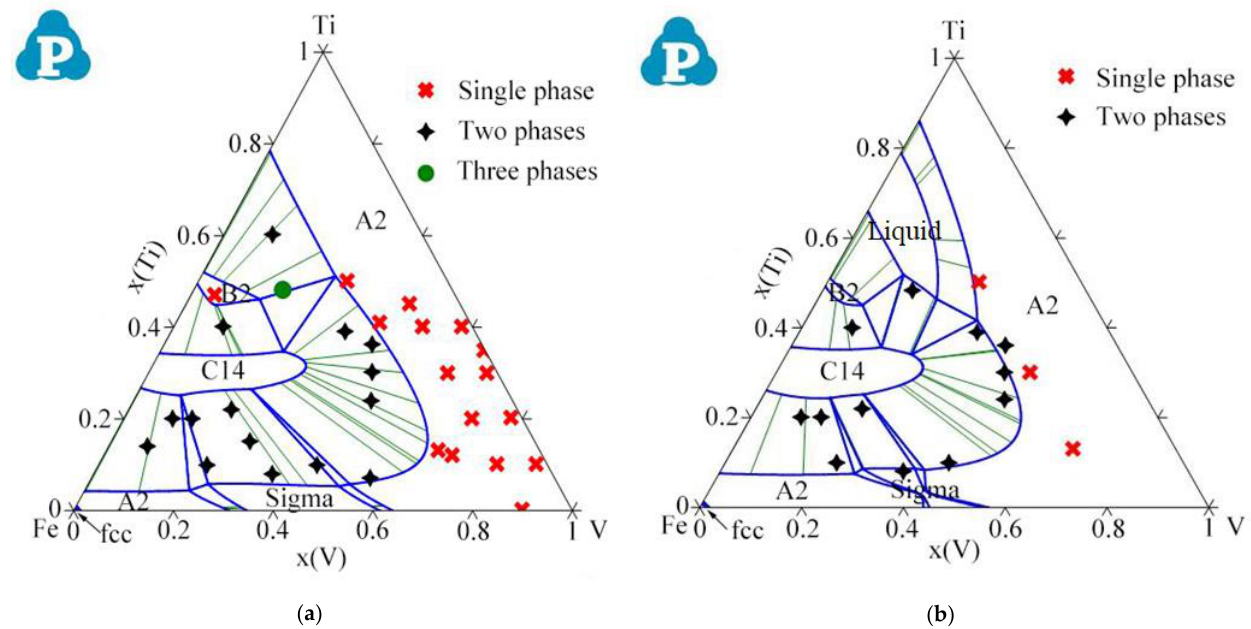
Figure 7. Calculated isothermal sections at ( a ) 1273 K and ( b ) 1473 K in the Ti-Fe-V system in comparison with experimental data [66].